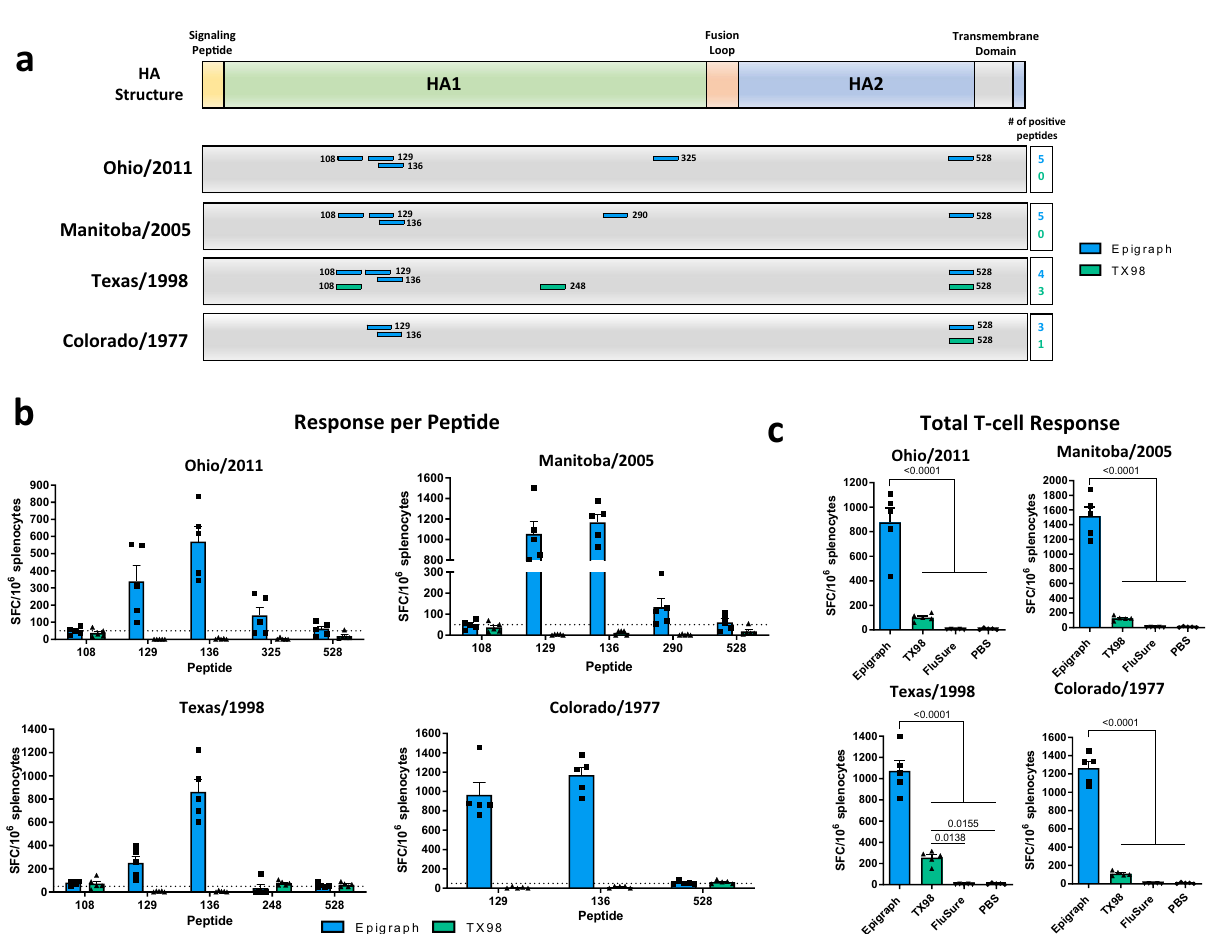
Fig. 3 T-cell epitope mapping of four diverse swH3 strains after vaccination. Splenocytes from vaccinated BALB/c mice ( n = 5) were isolated and analyzed for cellular immunity using an IFN γ ELISpot. T-cell epitopes against the Ohio/2011, Manitoba/2005, Texas/1998, and Colorado/1977 strains were mapped using an overlapping peptide array consisting of 17-mers with 10-amino acid overlap which spanned the entire hemagglutinin (HA) protein. Peptide responses >50 spot-forming cells (SFC) per million were considered positive. Positive peptides for each vaccine and their location on the HA protein are indicated ( a ). The peptide number designates the position of the last amino acid in the peptide on the total HA protein. The level of response against each positive peptide is reported as SFC per million splenocytes with the dotted line indicating the 50 SFC/million cutoff ( b ). The total T-cell response to each virus peptide array is shown for all vaccination groups ( n = 5; one-way ANOVA with Tukey ’ s multiple comparisons) ( c ). Data are presented as the mean with standard error